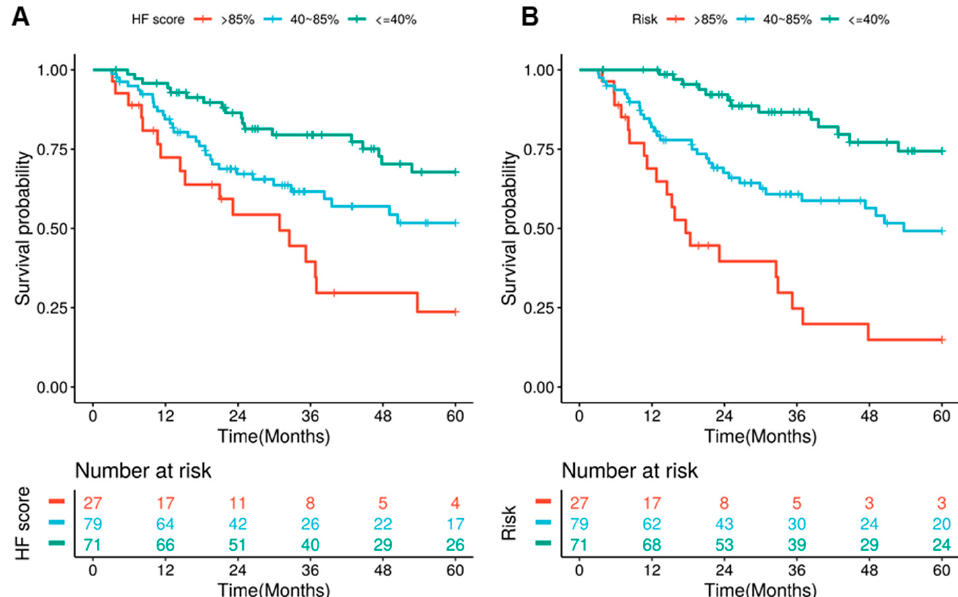
Figure 4. HF score and RSF prediction stratify the test cohort patients into distinct risk groups. The Kaplan–Meier estimates for the patient stratified based on the HF score ( A ) and risk predicted by RSF model ( B ) based on cutoffs of the 40th and 85th percentiles. The cutoffs were selected to be comparable with the H-index.